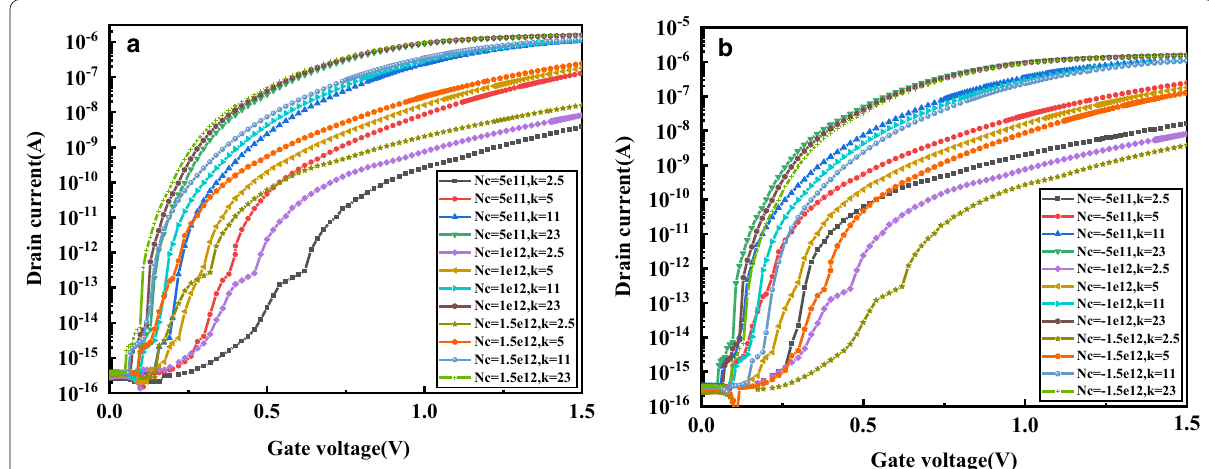
Fig.8 Transfer characteristics of DM-DSTGTFET biosensor for dielectric constant of biomolecules, a different positive charge and b different negative charge of biomolecules at V